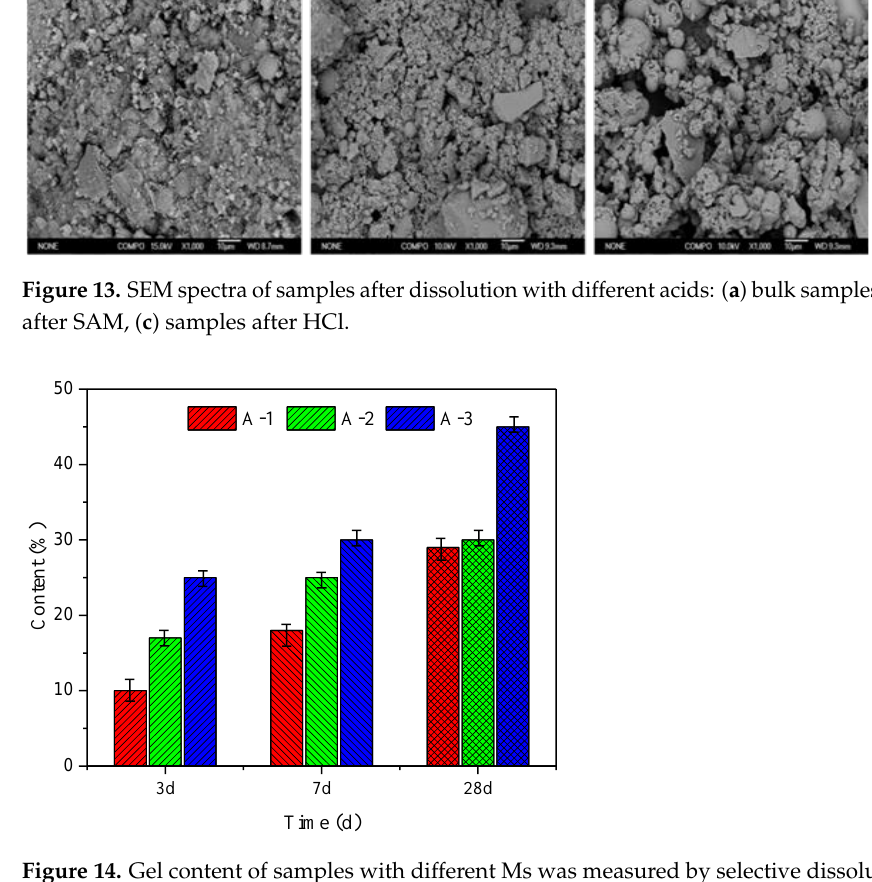
Figure 14. Gel content of samples with different Ms was measured by selective dissolution.